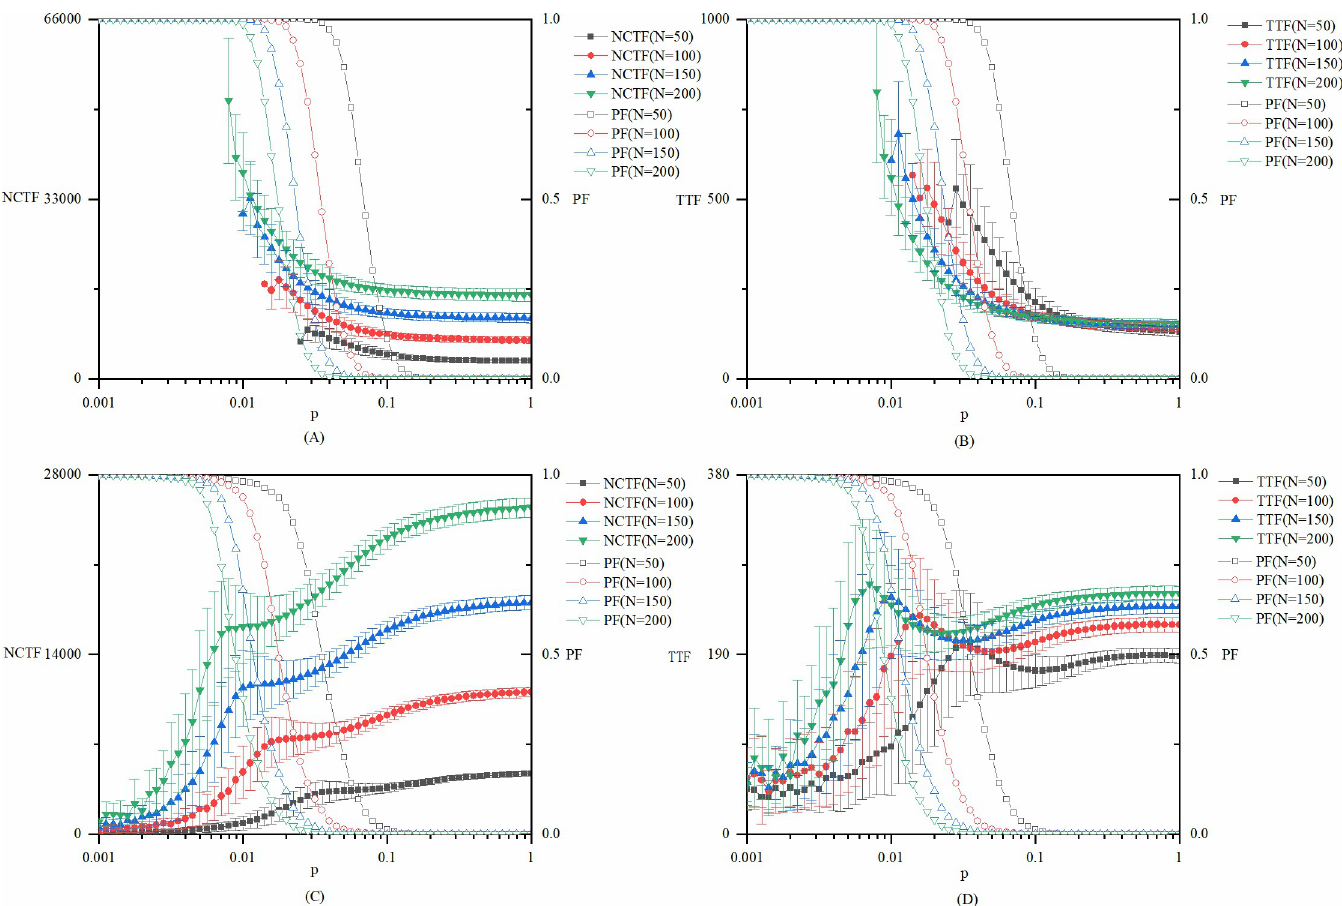
Fig 6. Robustness test of the network size N. (A) NCTF and PF of explorative innovations with different values of network size N . (B) TTF and PF of explorative innovations with different values of network size N . (C) NCTF and PF of exploitative innovations with different values of network size N . (D) TTF and PF of exploitative innovations with different values of network size N